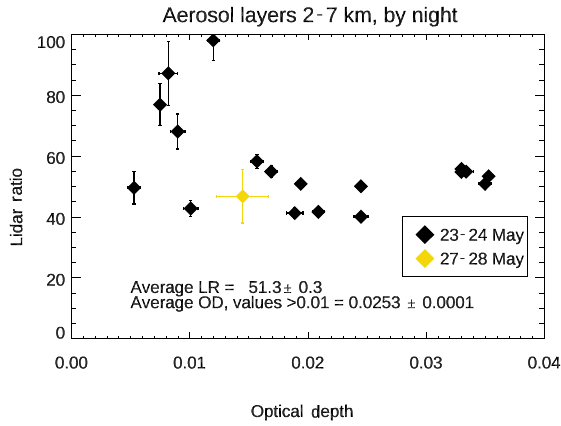
Figure 9. Lidar ratio plotted against total aerosol optical depth mea- sured from 2 to 7km by the Met Office Raman lidars on different nights.